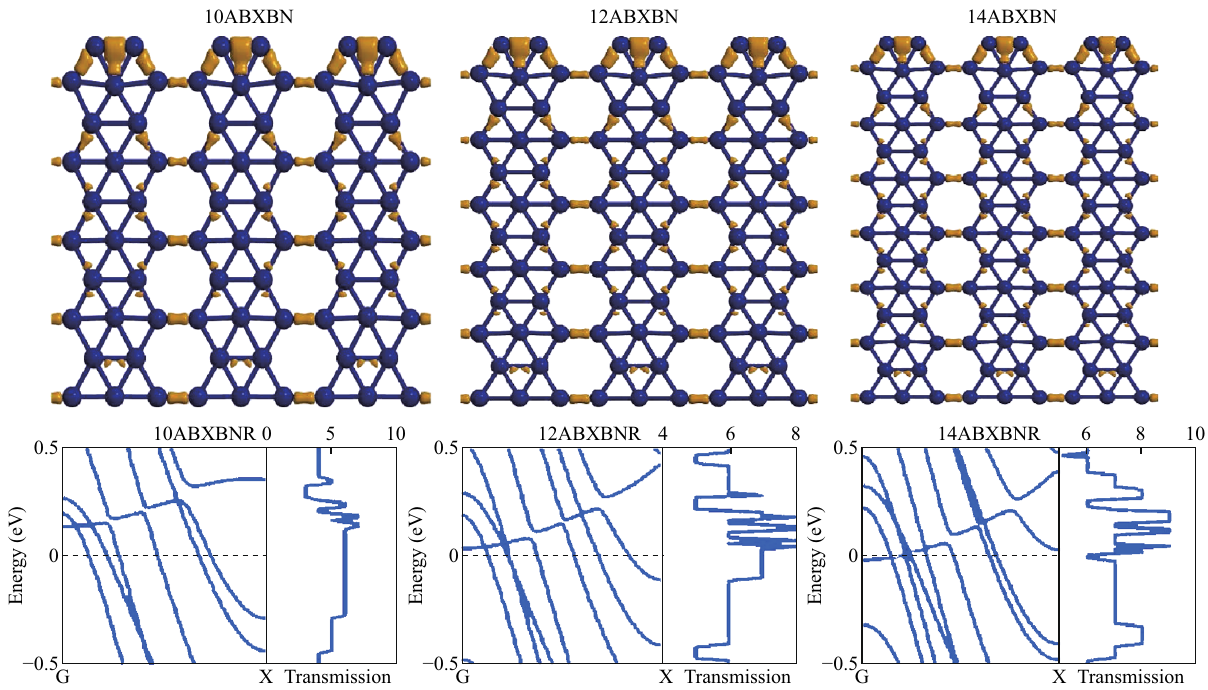
Fig. 6 Electron density (upper panels), the band structure, and the transmission channel (lower panels) of 10ABXBNR , 12ABXBNR , and 14ABXBNR